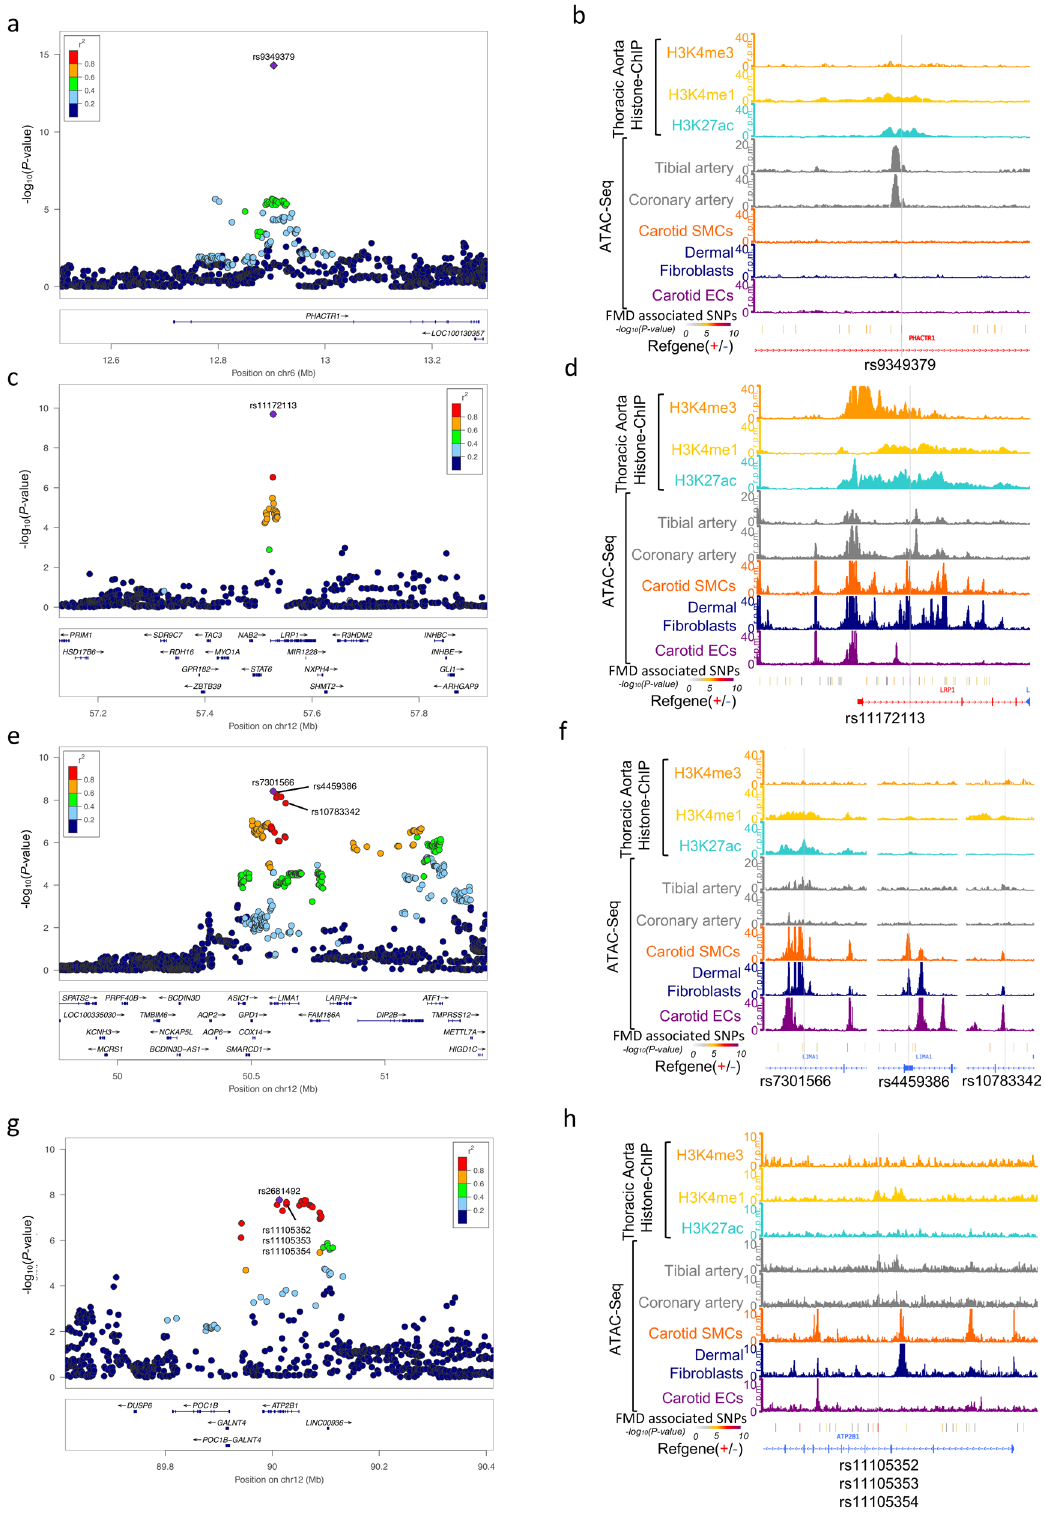
Fig. 3 Visualization of potential causal variants genes at FMD-associated loci. a , c , e , g LocusZoom representation of FMD-associated loci ( a PHACTR1 locus, c LRP1 locus, e LIMA1 locus, g ATP2B1 locus). Dot colour indicates LD of each variant with the highlighted lead variant (purple diamond). Position and rsID of putative causal variants are indicated. P value of genetic association is represented on the y -axis (negative log scale) ( b , d , f , h ) Genome browser visualization of ATAC-Seq/Histone-ChIP read densities (in reads/million, r.p.m.) in the regions surrounding putative causal variants. b PHACTR1 locus. d LRP1 locus. f LIMA1 locus. h ATP2B1 locus. Grey line highlights variant position.